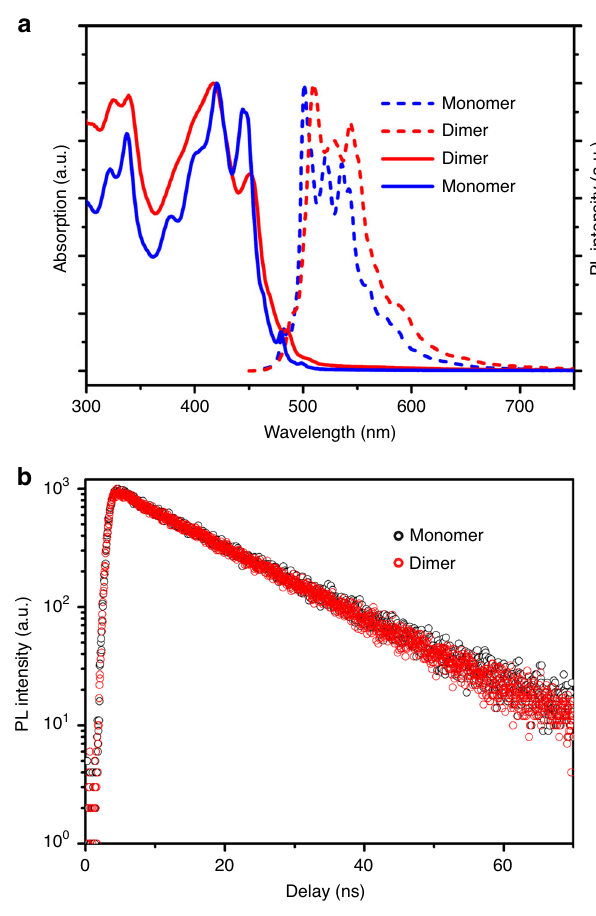
Fig. 7 Optical properties of 1 and (1) 2 . a Absorption (solid lines) and photoluminescence (PL) (dashed lines) spectra of 1 (blue) and ( 1 ) 2 (red). b . Time-resolved PL kinetics of 1 (black) and ( 1 ) 2